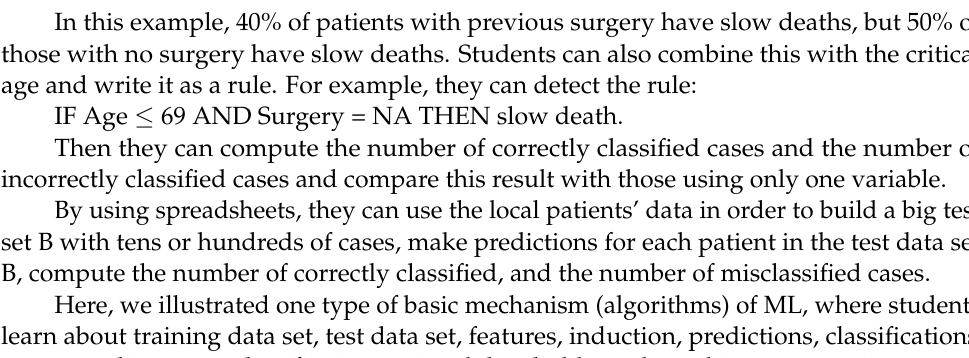
Figure 14. Two-dimensional scatter graph with variables surgery and Figure 14. Two ‐ dimensional scatter graph with variables surgery and age.